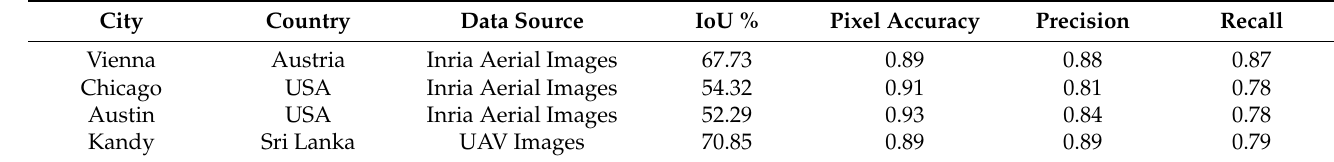
Table 1. Building detection accuracy for the four cities from the modified U-Net model.